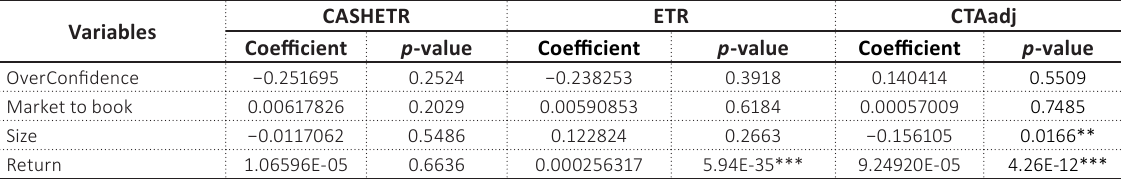
Table 5. Tax aggressiveness and overconfidence